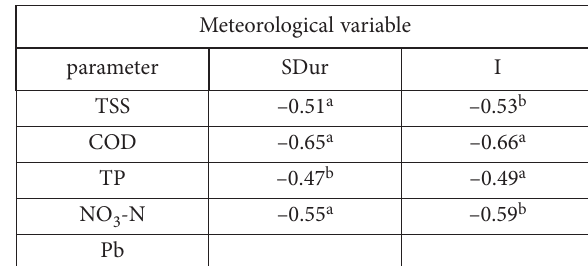
Table 5. Correlation coefficients between first flush load of pollutants (b value) and storm duration (SDur), mean rainfall